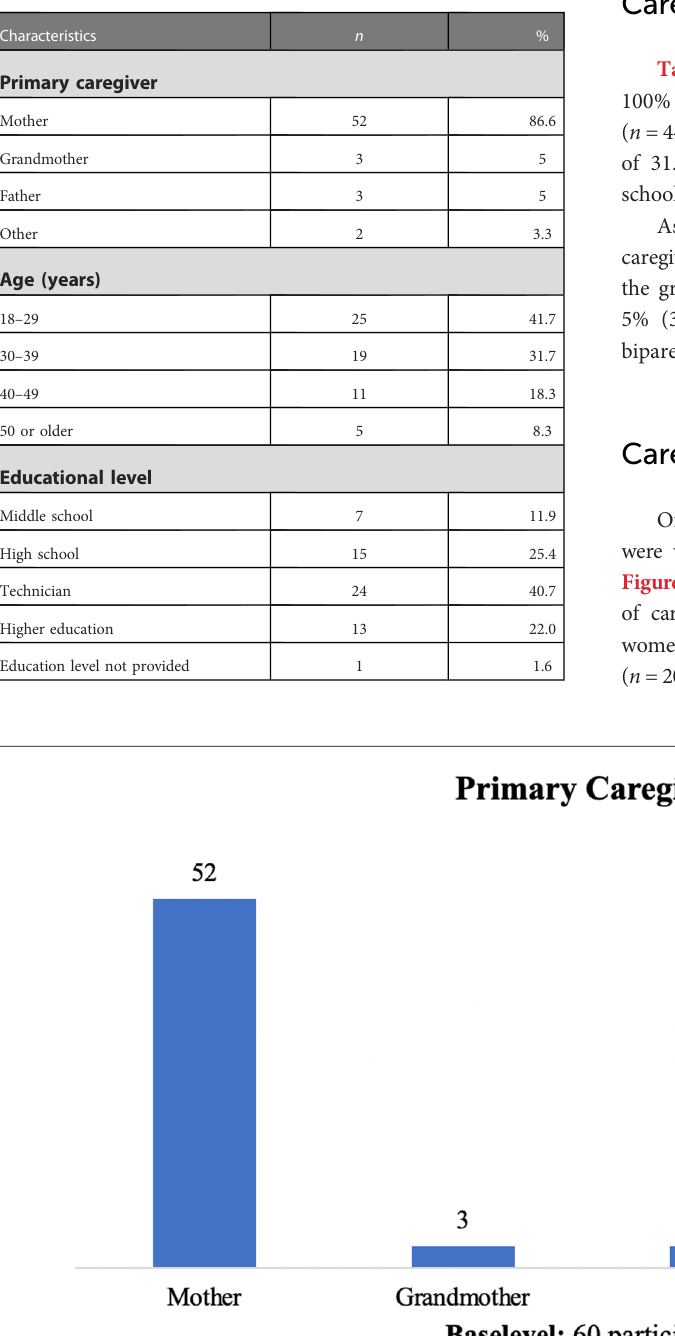
TABLE 2 Sociodemographic characteristics of caregivers.